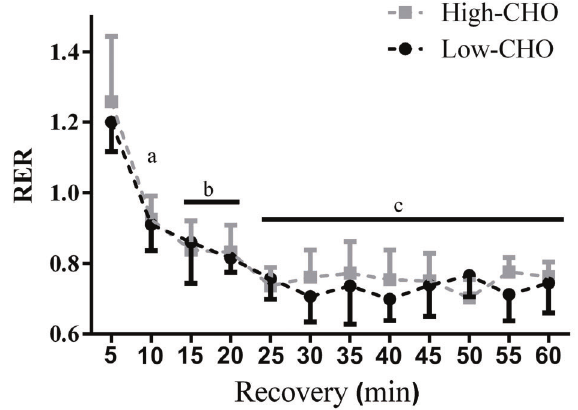
Figure 1. Respiratory exchange throughout the recovery of a . single, high-intensity exercise bout ( B 95% VO 2max ) performed under low- and high- carbohydrate (CHO) availability. Data are reported as means ± SD (n=8). a P o 0.05 compared to 5 min; b P o 0.05 compared to 5 and 10 min; c P o 0.05 compared to 5, 10, 15, and 20 min (ANOVA). RER: respiratory exchange ratio.